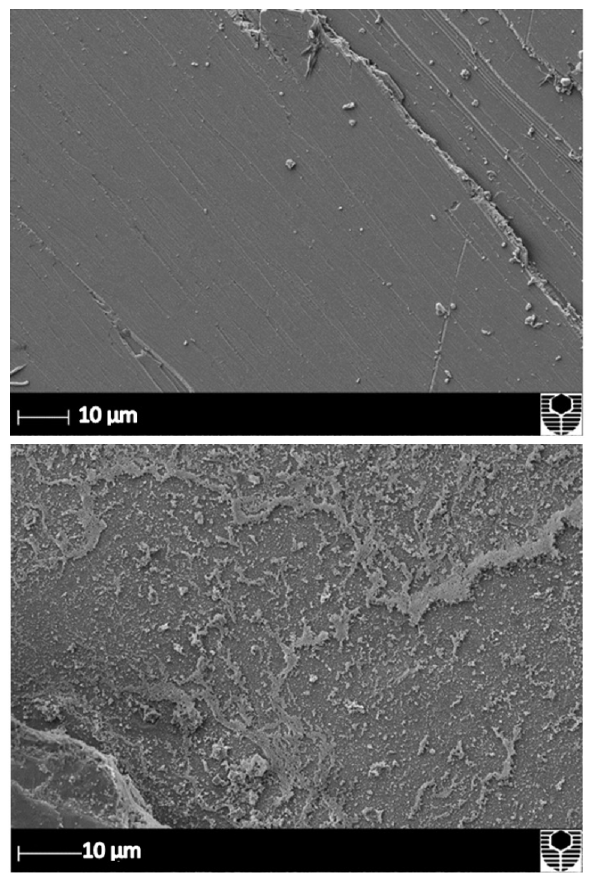
Figure 14. SEM images of an oil-wet calcite surface before ( top ) and after ( bottom ) the nanofluid treatment with 4 wt% SiO 2 in 5 wt% NaCl brine, showing the irreversibly adsorbed silica nanoparticles. Figure reproduced from Ref. [90].